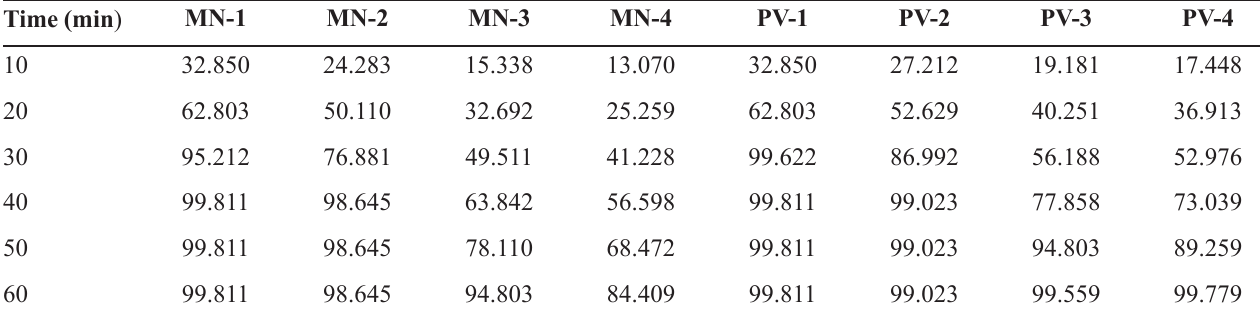
TABLE VI - In vitro release of diclofenac sodium